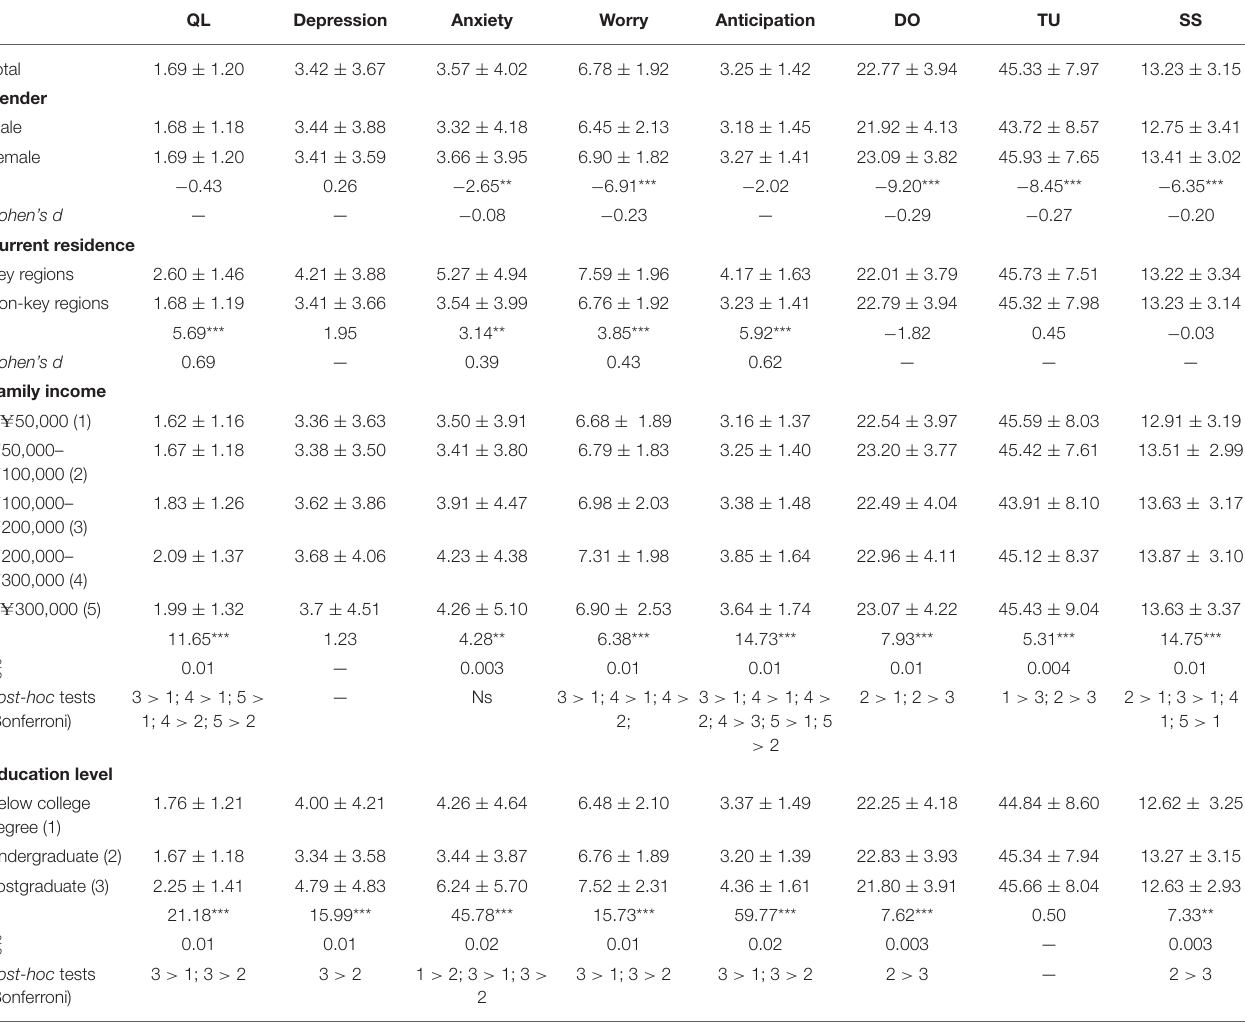
TABLE 1 | Descriptive statistics of and difference in demographic variables of all study variables ( M ± SD ). QL Depression Anxiety Worry Anticipation DO TU